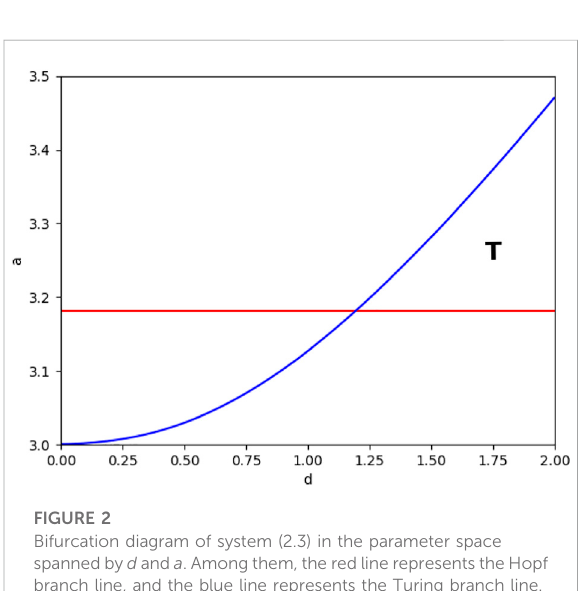
FIGURE 2 Bifurcation diagram of system (2.3) in the parameter space spanned by d and a . Among them, the red line represents theHopf branch line, and the blue line represents the Turing branch line. The Turing area is marked with T. The parameter values are d m = 1.5, d 1 = 1, and 2 =